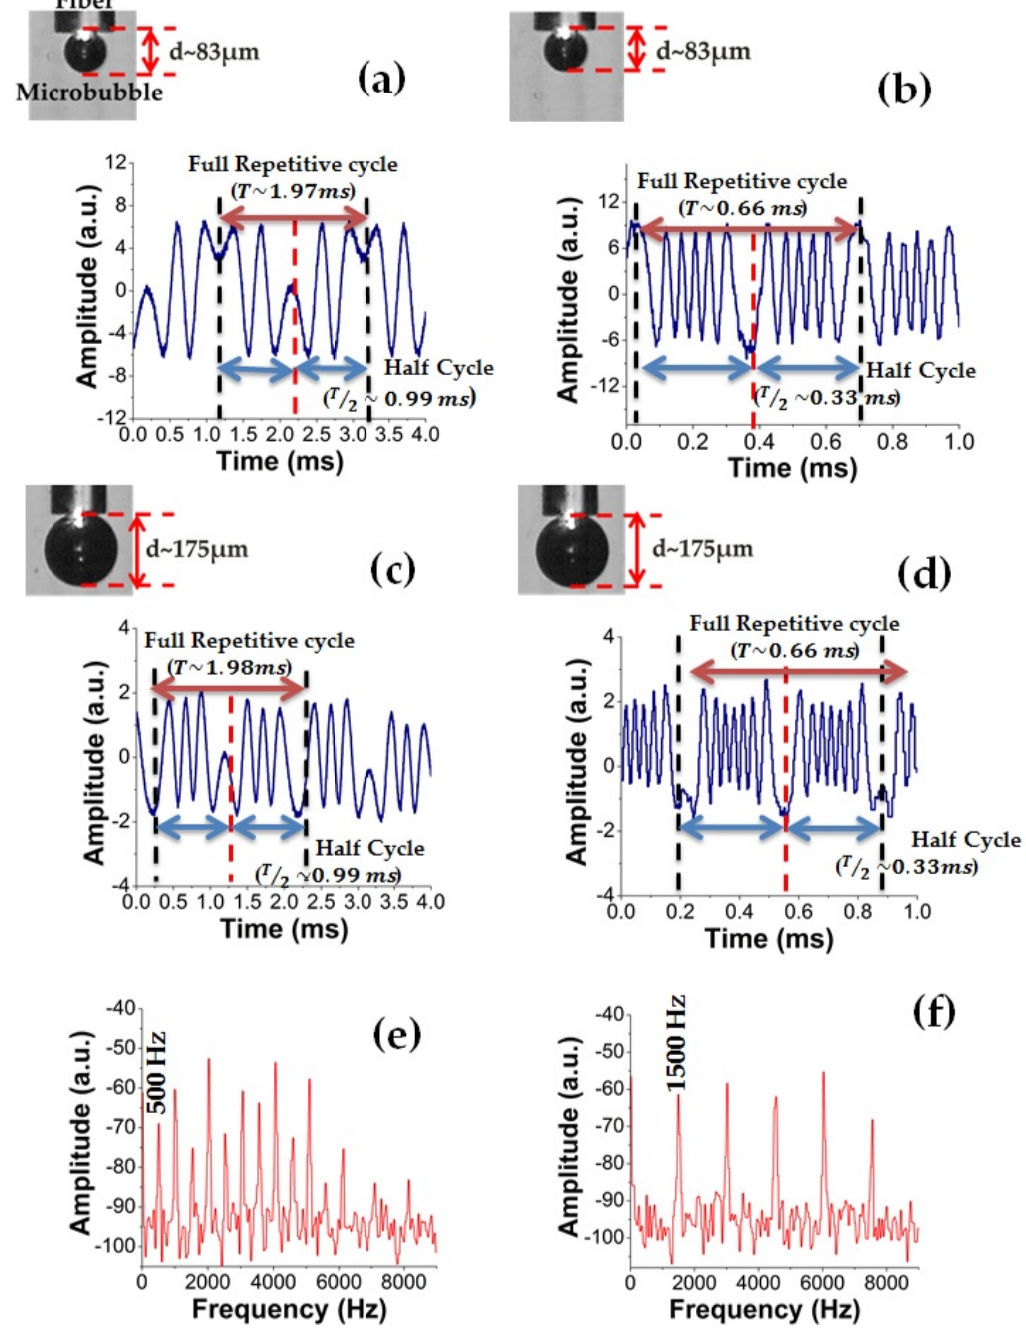
Figure 8. Real time of the vibration sensor using a microbubble with a diameter of ( a , b ) 83 µ m and ( c , d ) 175 µ m. ( e , f ) Fast Fourier Transform obtained with the oscilloscope from signals shown in ( a , b ),